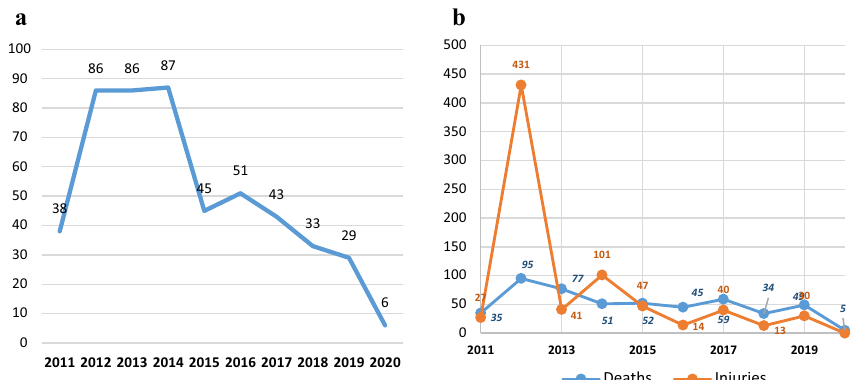
Fig. 2 a Total annual number of maritime accidents (2011–2020). Source: Based on IMO dataset. b Total annual number of deaths and injuries in maritime accidents (2011–2020). Source: Based on IMO